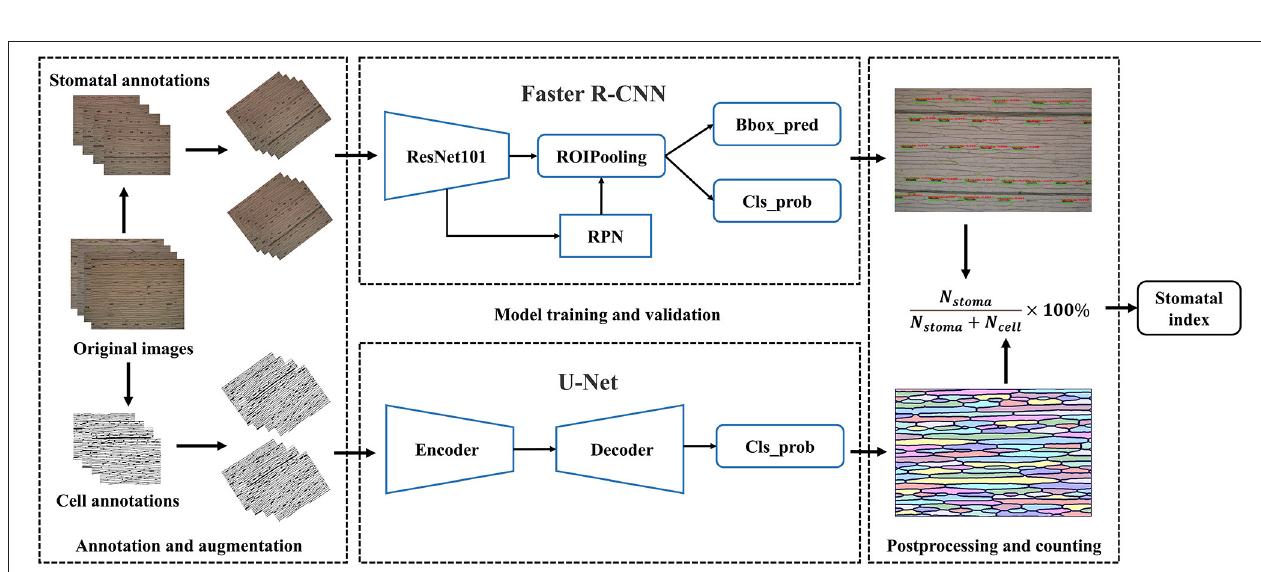
FIGURE 2 | A flow chart of the proposed pipeline of the stomatal index measurement.